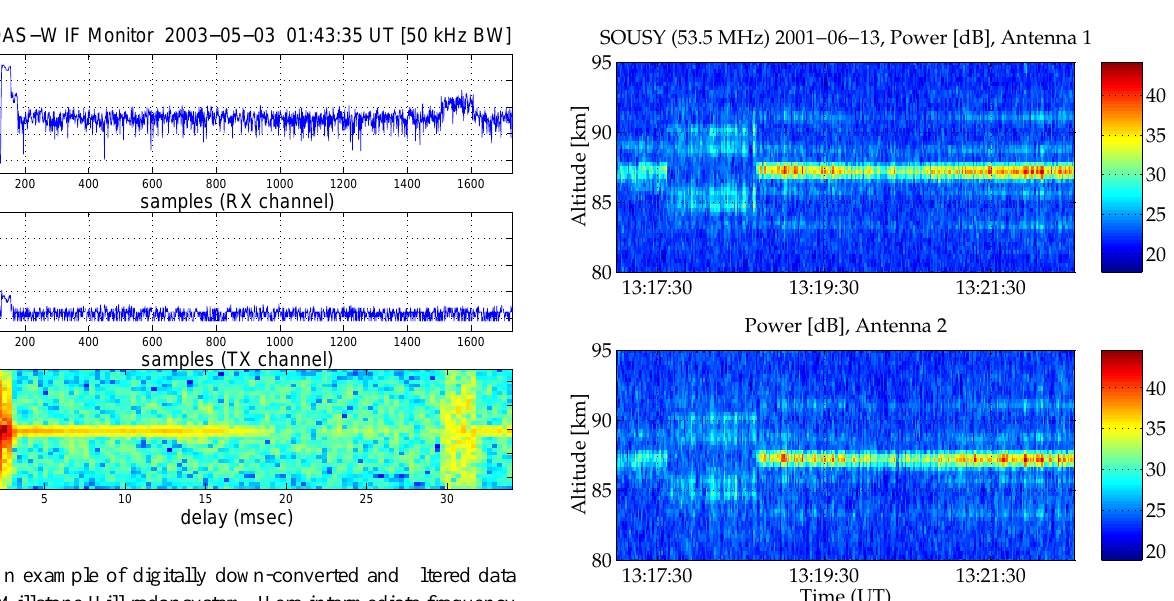
Fig. 4. An example of digitally down-converted and filtered data from the Millstone Hill radar system. Here intermediate frequency (IF) data at 500kHz of bandwidth has been down-converted and fil- tered in real time to 50kHz bandwidth data. The resulting 50kHz bandwidth data is shown for the main receive (RX) and transmit- ter digitization (TX) channels. The bottom panel shows a spectral analysis of the RX signal.